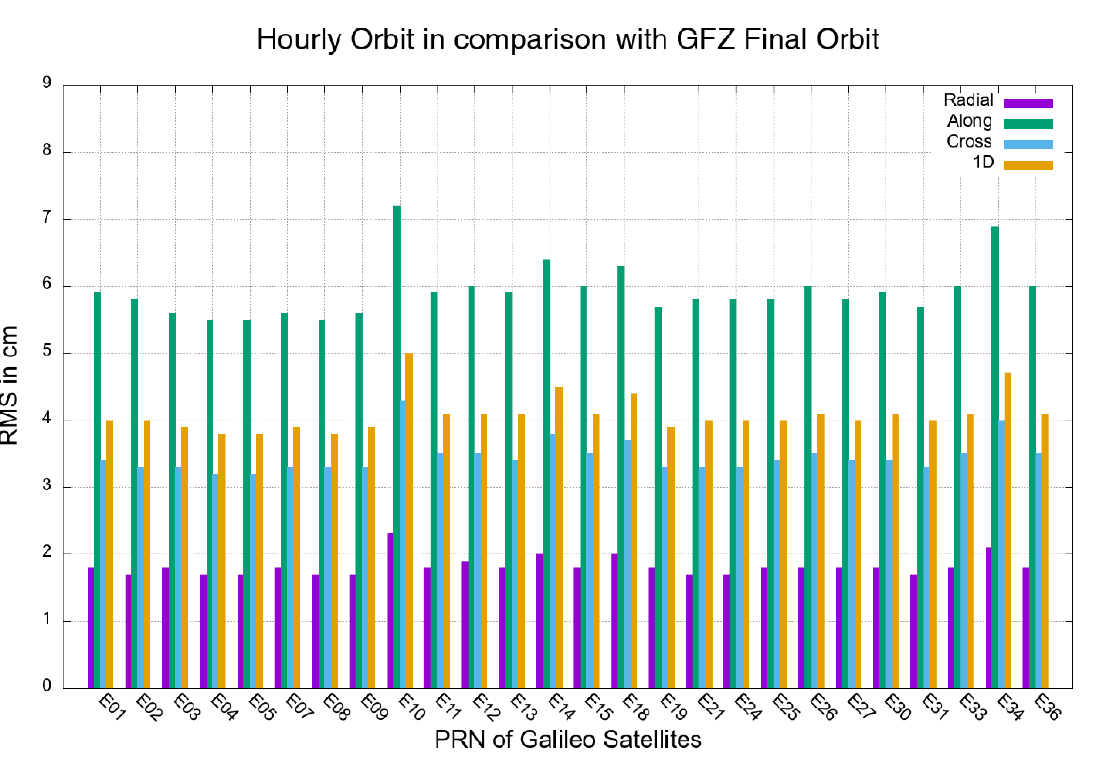
Figure 6. Mean RMS in the RAC components and 1-D of GLONASS satellites in comparison with GFZ final orbit.